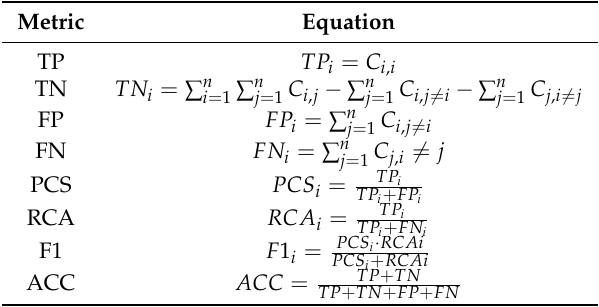
Table 3. Machine Learning algorithms performance